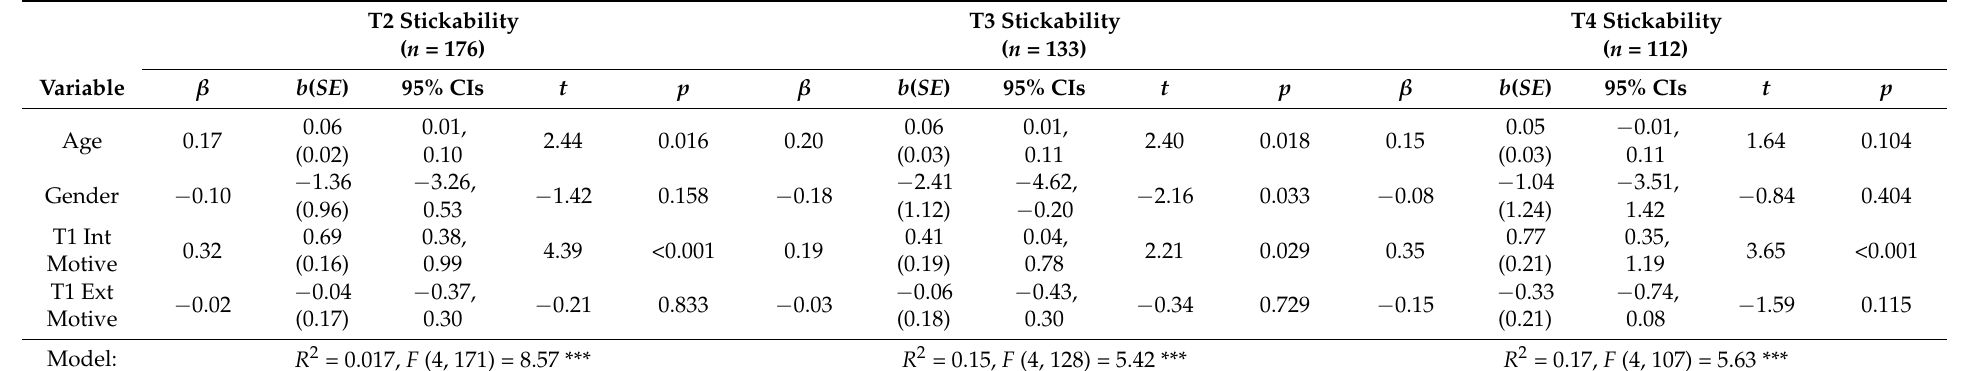
Table 5. Intrinsic and extrinsic motives as predictors of resolution stickability from Time 2 to Time